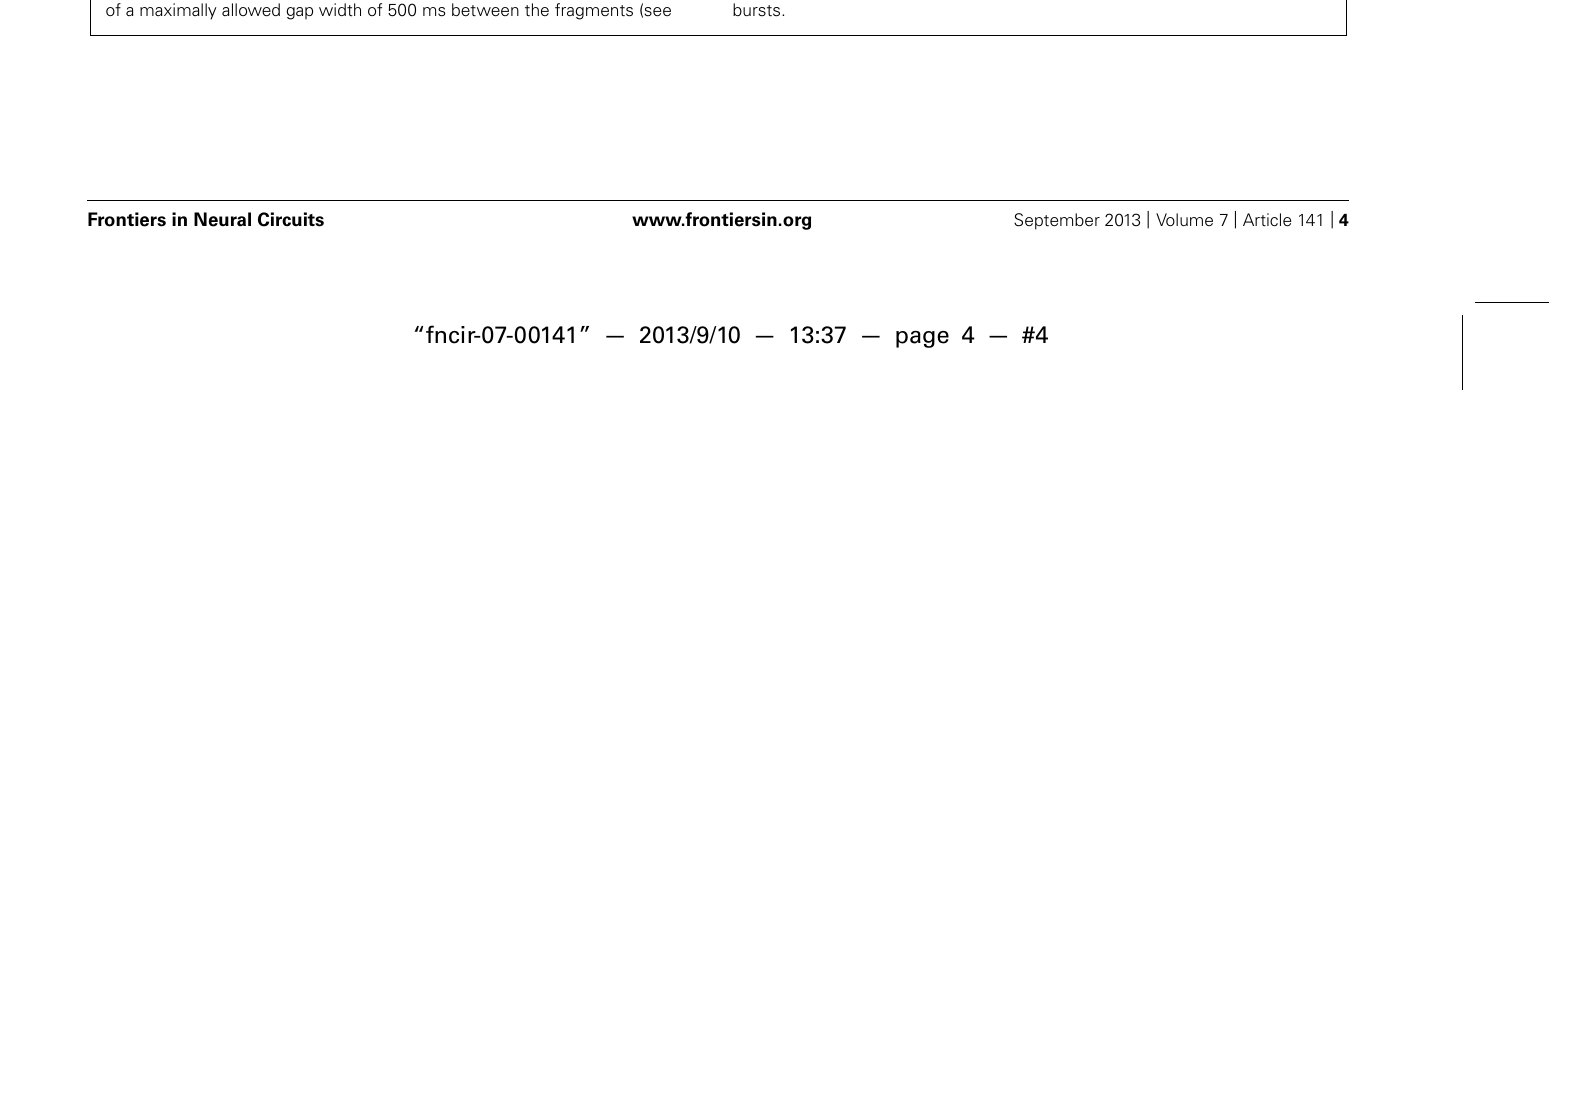
FIGURE 1 | Spontaneous activity patterns in organotypic slice cultures of rat neocortex. (A) Paired current clamp recording of a putative fast-spiking interneuron (upper trace) and a putative pyramidal neuron (lower trace) which were separated by ∼ 150 μ m and not connected to each other. Insets to the right represent spike responses to depolarizing current injections during silent periods. Both neurons were in infragranular layers. (B) Example of a paired current clamp (upper trace) and extracellular recording (lower trace, broadband signal, 1–5000 Hz). As in (A) , inset depicts the neuron’s spiking response. (C) Expanded view of burst marked by asterisk in (B) . Upper trace represents the current-clamped neuron’s membrane potential with action potentials clipped at − 20 mV.Turquoise and overlaid black trace in the second row from top represent the extracellular broadband trace and the local field potential (LFP) component, respectively.Third trace from top is the rectified LFP trace (LFP rect ) which was used to detect bursts via a threshold (dotted line). Scattered line fragments below the trace are the portions of LFP rect above threshold. Continuous line represents the burst as defined on the basis of a maximally allowed gap width of 500 ms between the fragments (see